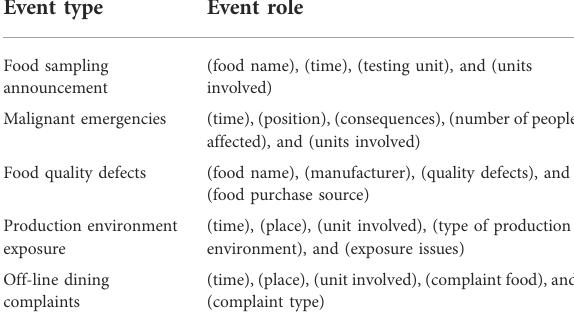
TABLE 3 Pre-de fi ned event schema of